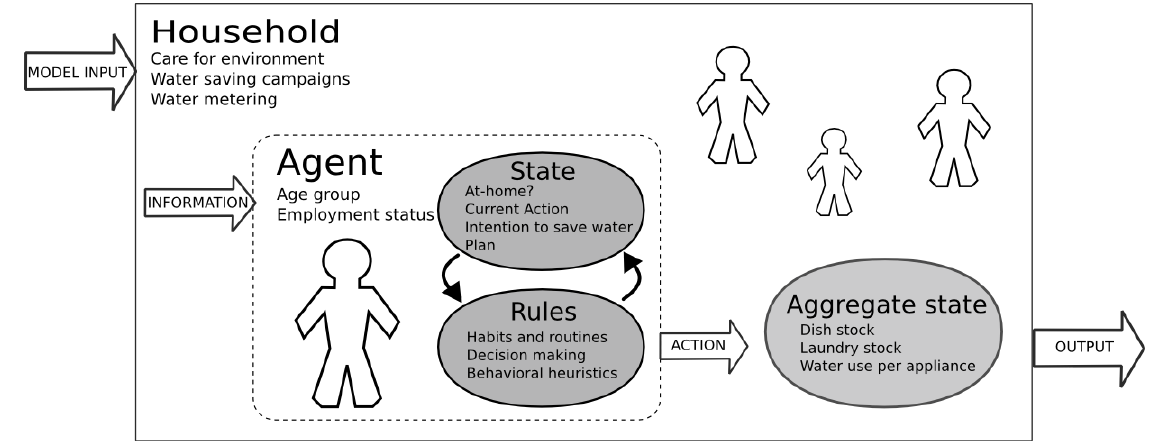
Figure 2. System structure: The units of enquiry in the model are individual agents. Agents acquire information from the environment which affects agent state. Agents behave according to rules. Agents form households, the behavioral system to be observed. The household state is the result of the agent actions; we call it the aggregate state. Agent actions are triggered by their